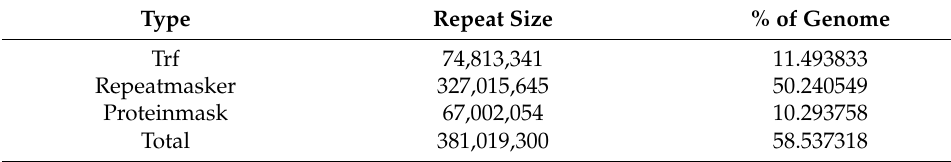
Table 4. Summary of repeat contents in C. roscoffensis